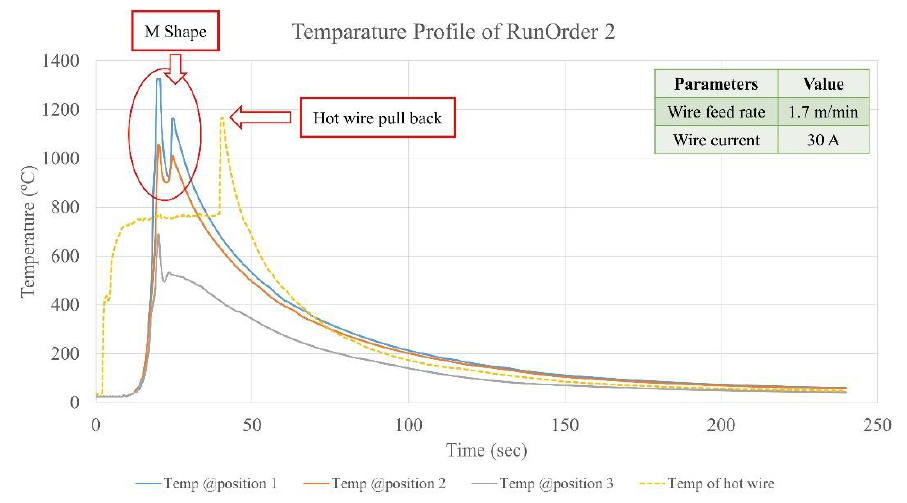
Figure 9. The temperature profile of run order 2.